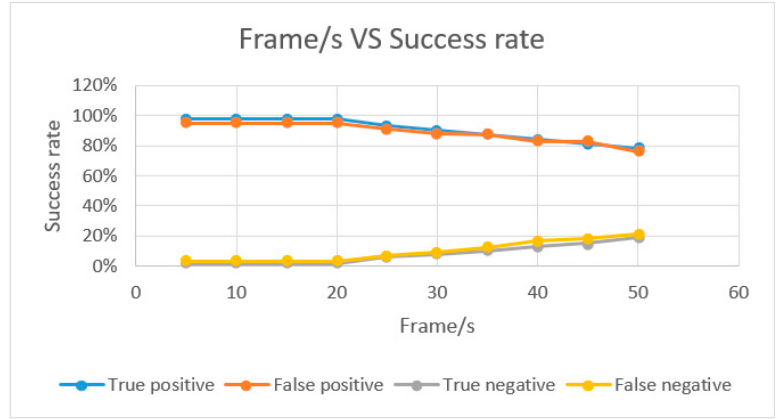
Figure 20. Real-time performance.